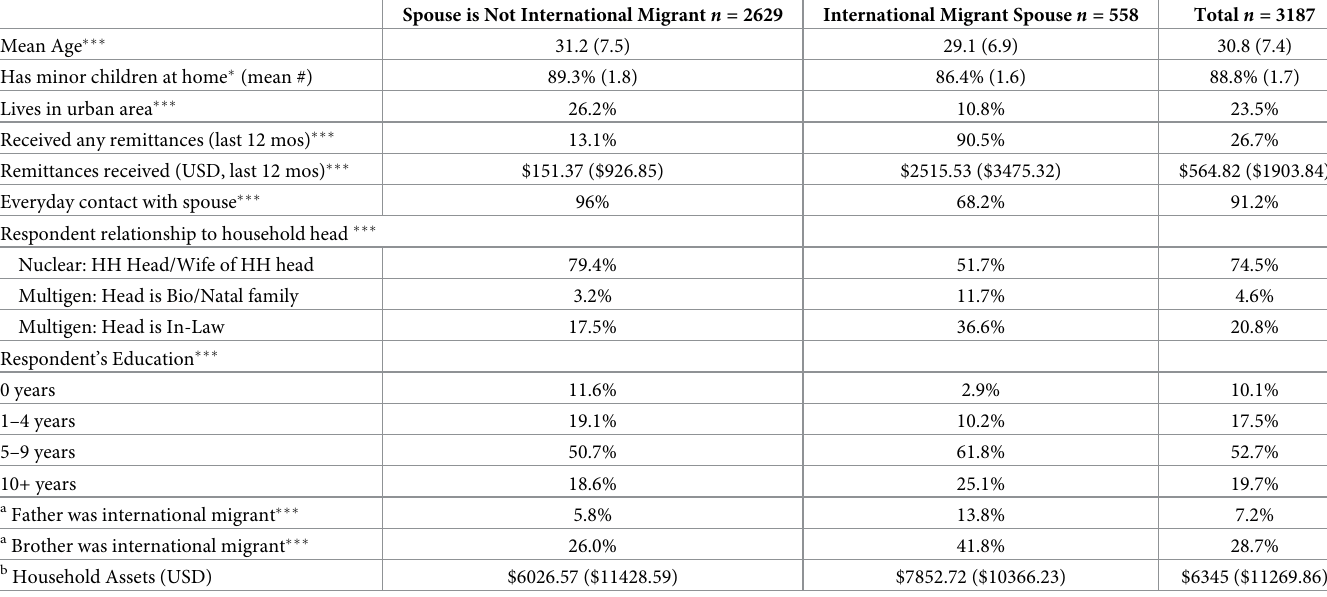
Table 1. Characteristics of respondents, by spousal migration status.